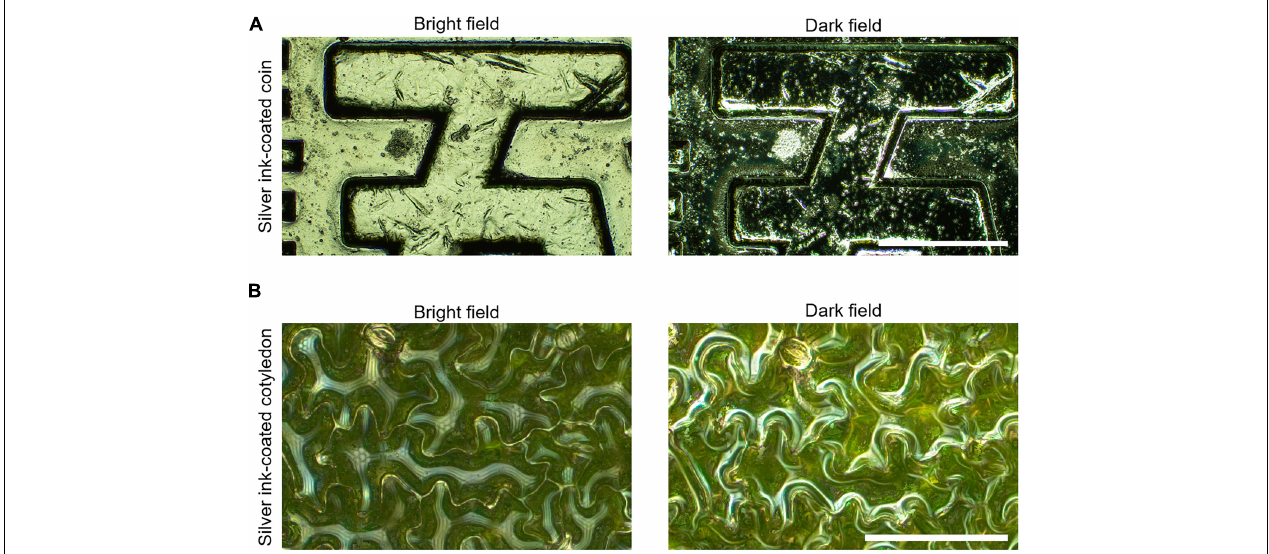
FIGURE 2 | Evaluation of illumination methods for visualizing cotyledon epidermal cell contours by metallographic microscopy. (A) Omnifocal metallographic images of the surface of the silver ink-coated coin captured with bright-field (left) and dark-field (right) illumination. Scale bar indicates 500 µ m. (B) Omnifocal metallographic images of the surface of a cotyledon coated with silver ink captured with bright-field (left) and dark-field (right) illumination. Scale bar indicates 100 µ m. The surface microstructure of both the coin and the cotyledon surface was better observed with the bright-field illumination than with the dark-field illumination.